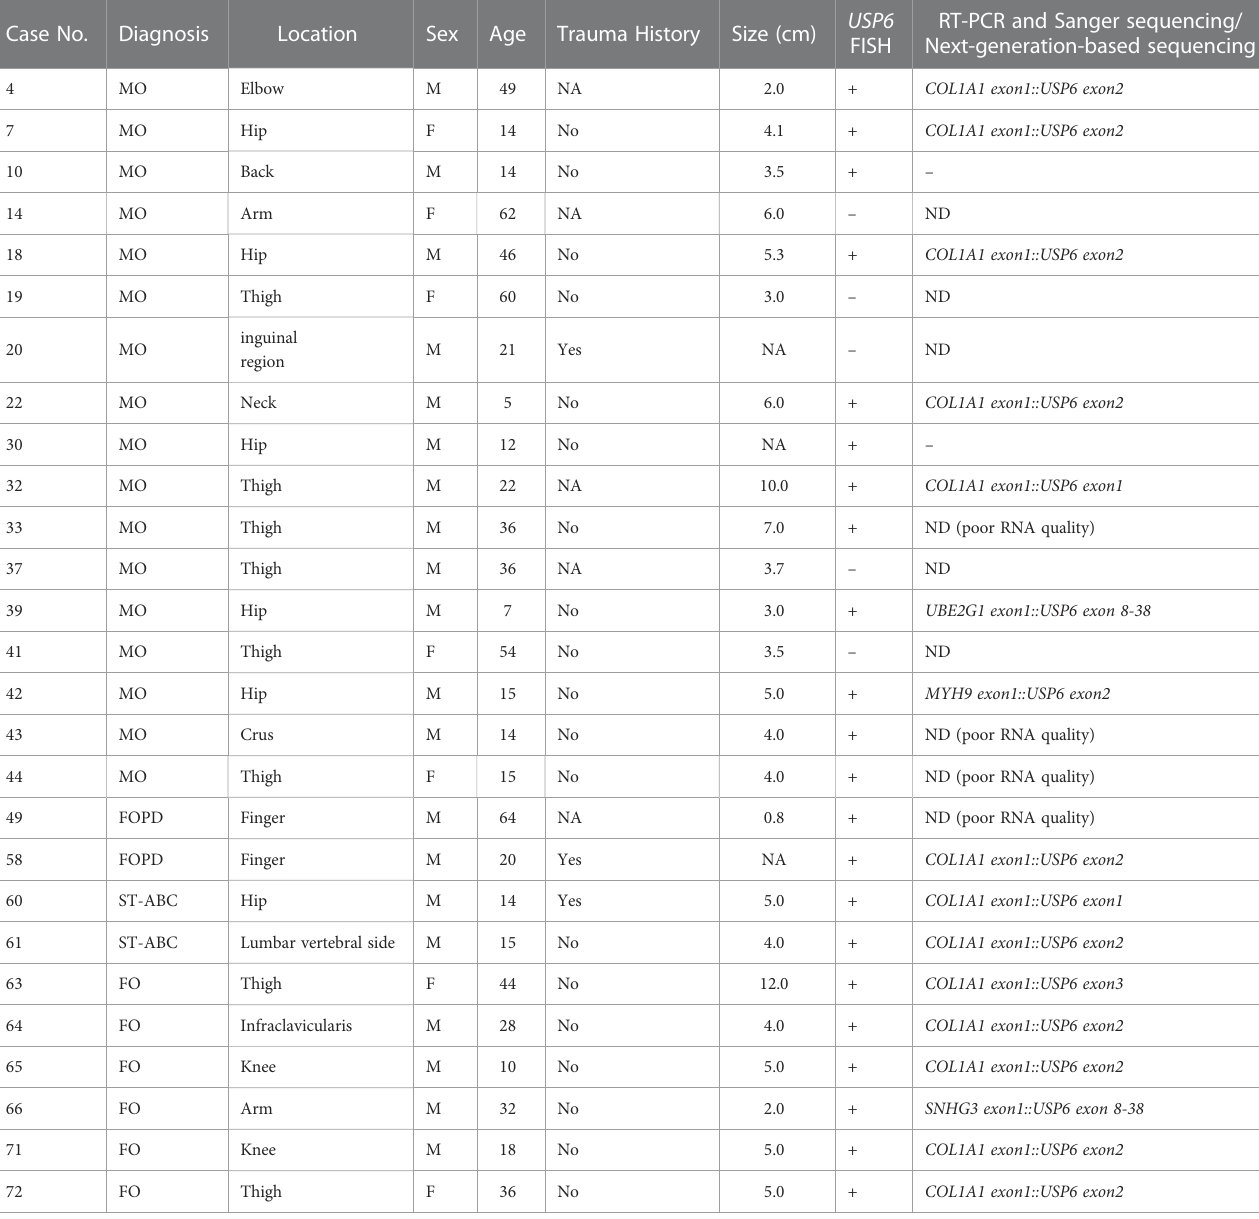
TABLE 1 Genetic fi ndings of USP6 -associated soft tissue tumors with bone metaplasia.